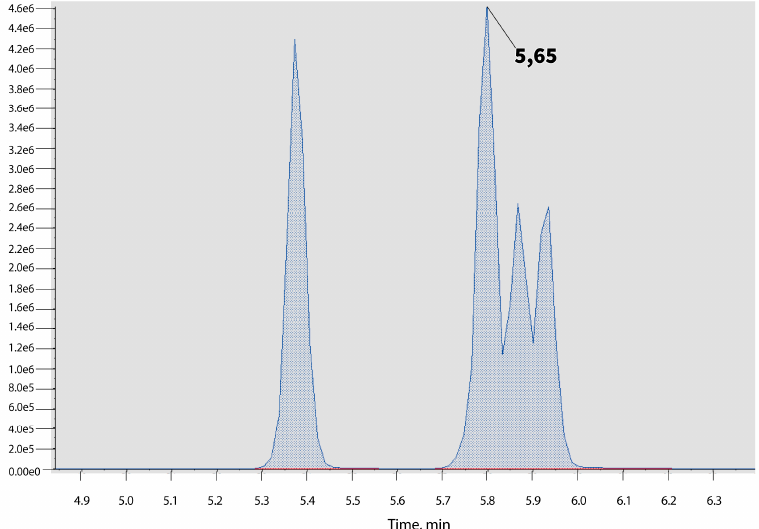
Figure 3. Unresolved chromatographic peaks for ADB-PINACA and its isomers.